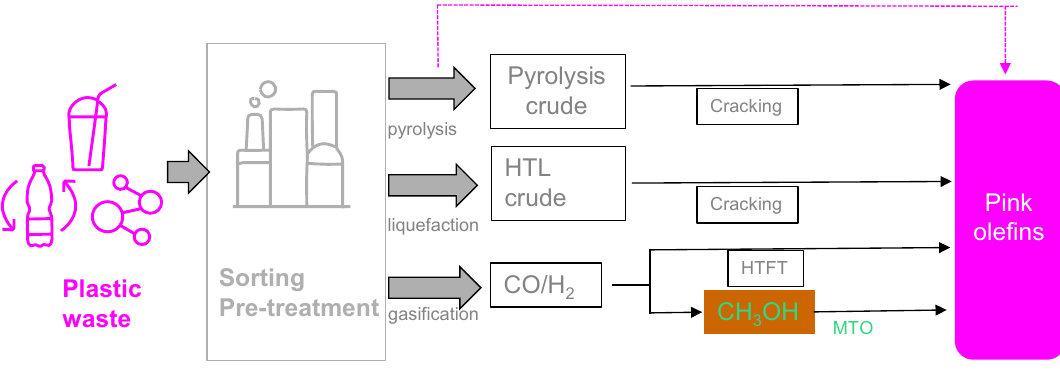
Fig. 4 Main conversion paths for waste plastic based pink olefins